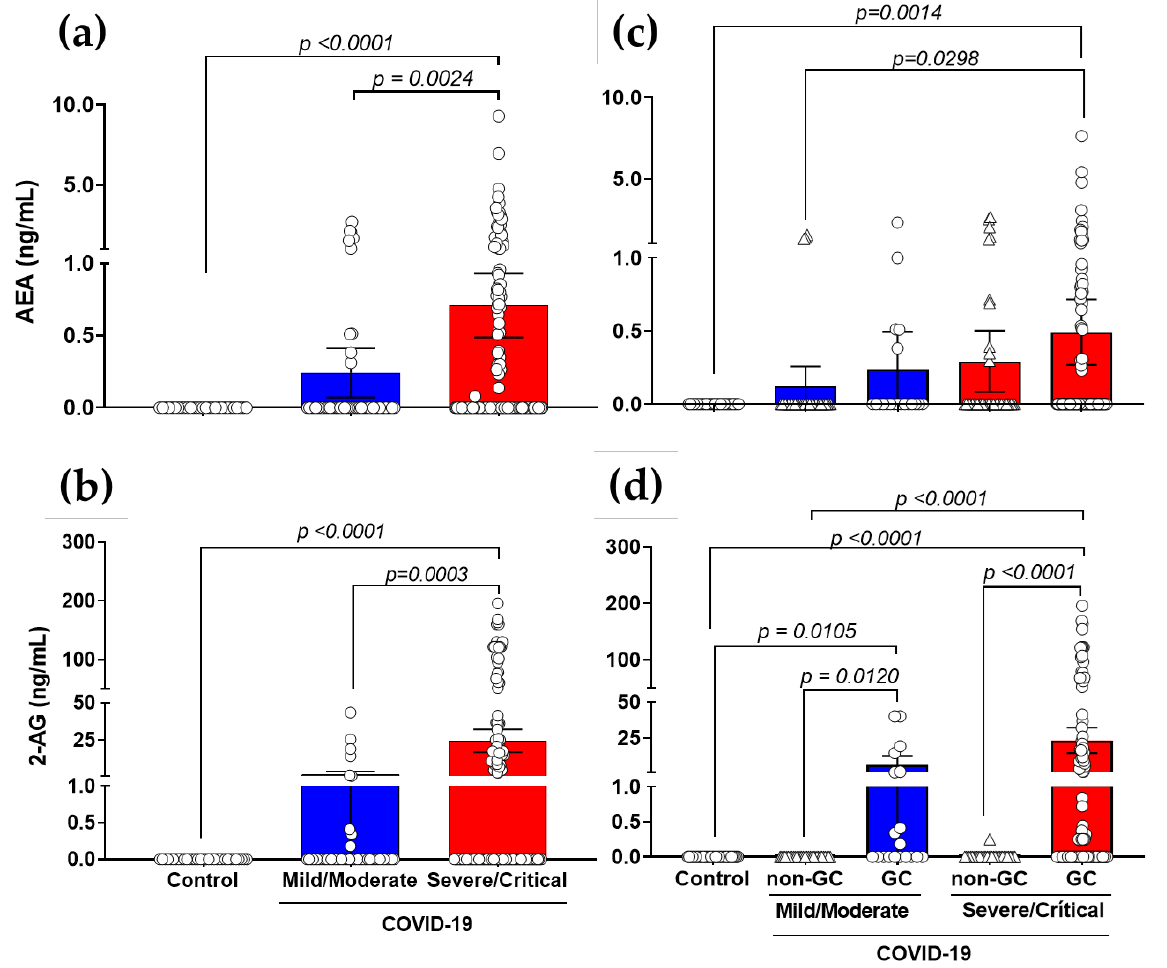
Figure 1. Production of plasma AEA and 2-AG in patients with COVID-19 using GC treatment. Levels of AEA ( a ) and 2-AG ( b ) in COVID-19 patients (mild/moderate, n = 55 and severe/critical, n = 145) compared to healthy controls ( n = 35). COVID-19 patients who use/do not use GC were seg- regated into mild/moderate (non-GC, n = 35 vs. GC, n = 20) and severe/critical (non-GC, n = 42 vs. GC, n = 103), showed production of AEA ( c ) and 2-AG ( d ) compared to healthy controls. Statistical analyses were performed using the Kruskal – Wallis multiple comparison test (non-parametric), followed by Dunn ’ s post-test. Data are expressed as median in boxplot graphs with minimum and maximum values w ith a confidence interval of +/− 95%. Significance levels shown are based on statistically significant p -values between groups, considering significant with p < 0.05. 3.3. Diminished Levels of Lyso-PAF and PAF, and Different Ratios in Lyso-PC and Lyso-PE Species in Severe COVID-19 Patients with the Use of GCs When we compared PAF plasma production in different COVID-19 severities, we discovered an inverse phenomenon to what happens with eCB production. Descriptive analyses showed a reduction of Lyso-PAF (16:0) (Figure 2a), Lyso-PAF (18:0) (Figure S1a), PAF (16:0) (Figure 2b) and PAF (18:0) (Figure S1b) production in severe/critical COVID-19 patients compared to mild/moderate patients ( p < 0.0001) and control subjects ( p < 0.0001). In addition, when dividing the groups according to pharmacological treat- ments with GCs, we observed that the individuals who used GC showed a reduction in